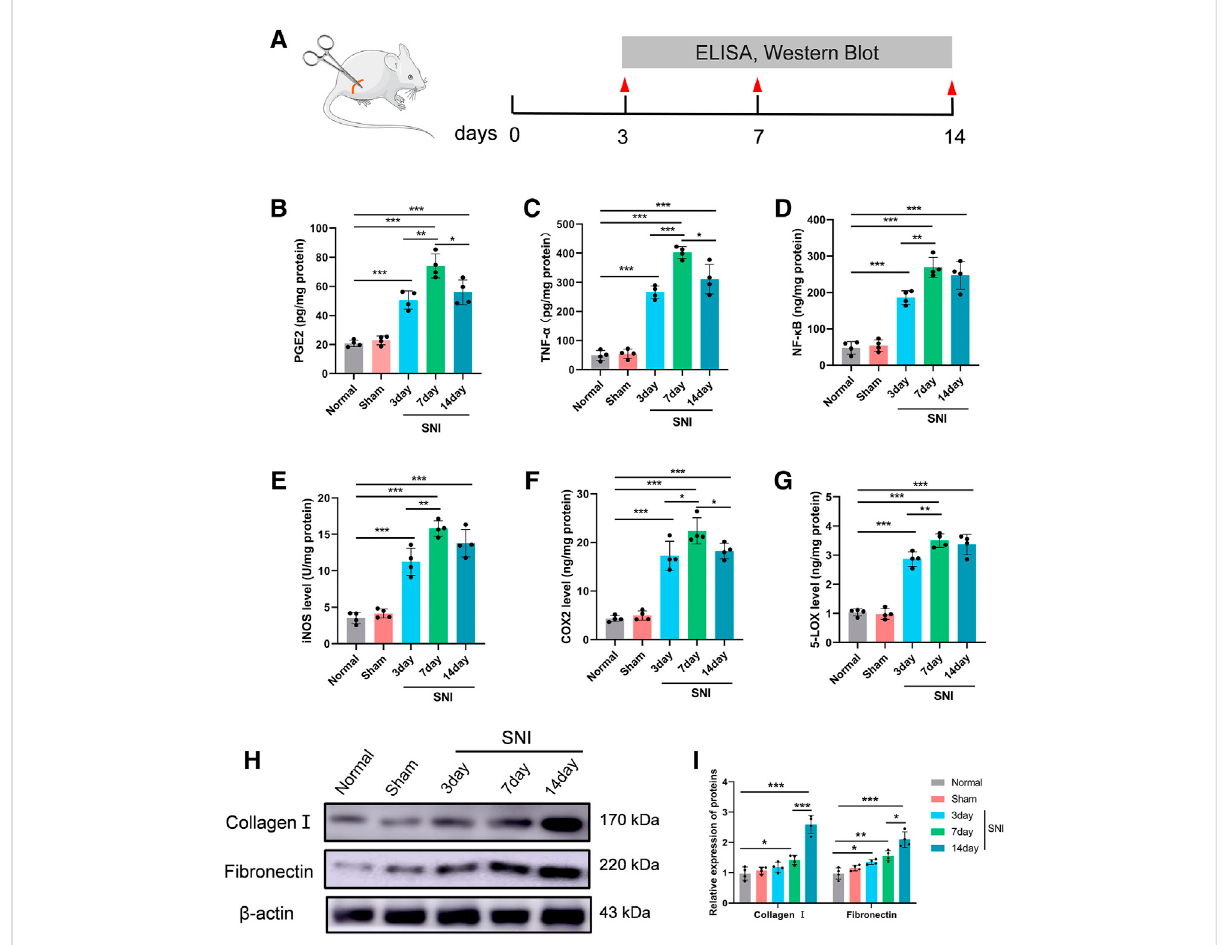
FIGURE 4 Thelevelofin fl ammatory-andscar-relatedproteinintheDRG. (A) Experimentalparadigm. (B) PGE2, (C) TNF- α , (D) NF- κβ , (E) iNOS, (F) COX-2, and (G) 5-LOX in DRG tissues. (H) The expression of collagen I and fi bronectin in DRG tissues at 0, 3, 7, and 14 days following injury, as evidenced by western blot analysis. (I) Protein data quanti fi cation from (H) . Data are provided as mean ± SD, with n = 4 per treatment. * p < 0.05, ** p < 0.01, and *** p < 0.001 were deemed signi fi